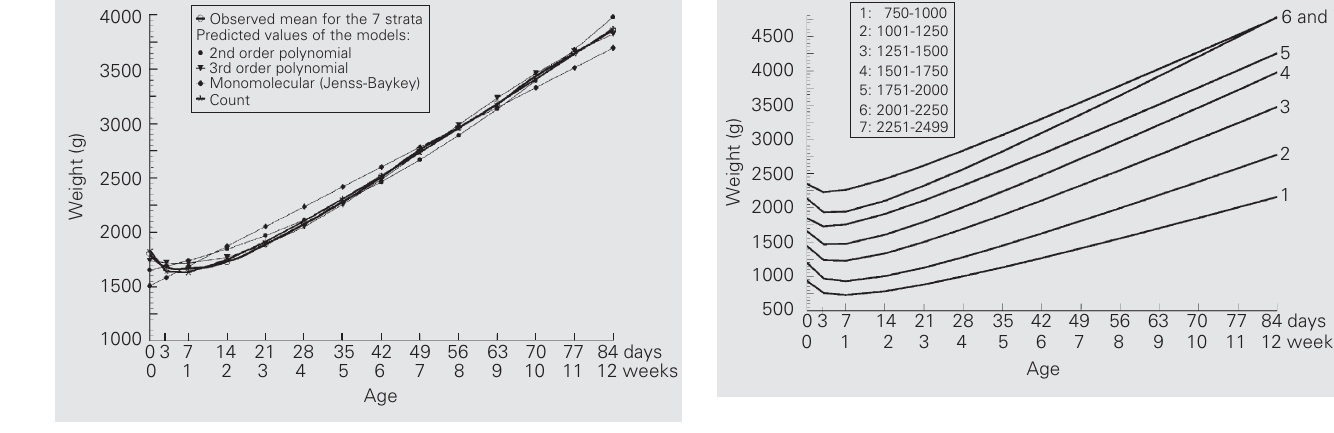
Figure 1. Comparison of the mathematical models evaluated in terms of the observed mean.